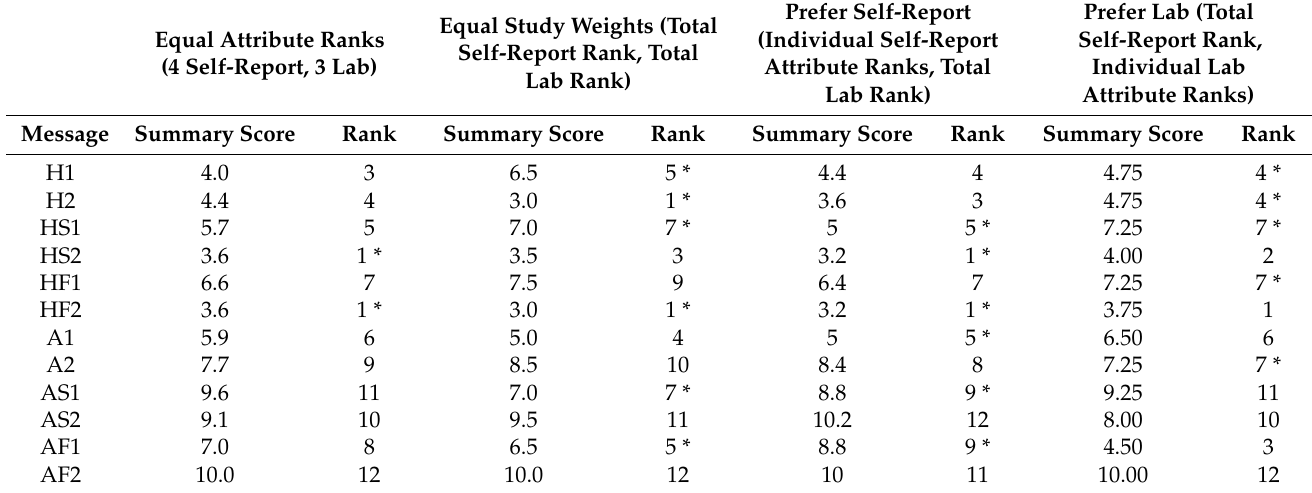
Table 2. Ranking of waterpipe tobacco smoking messages by weighting